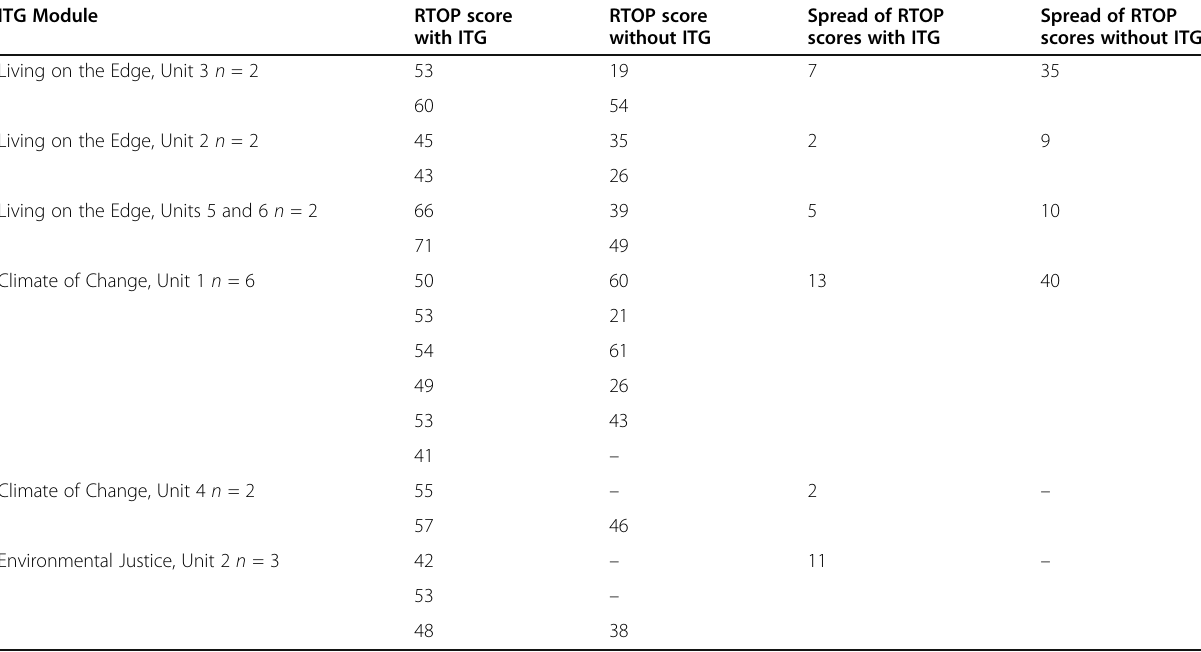
Table 5 Comparison of RTOP scores for instructors teaching with the same ITG materials ITG